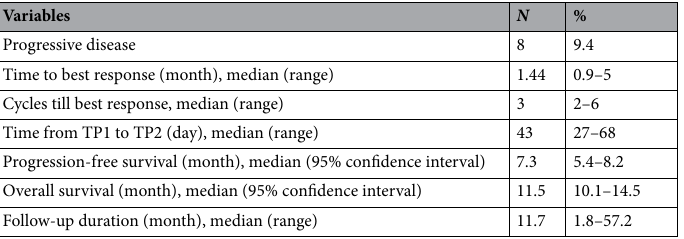
Table 1. Baseline characteristics of the study population. a Other regimen includes capecitabine (n = 3) and folfirinic acid/cisplatin plus pembrolizumab (n = 1).